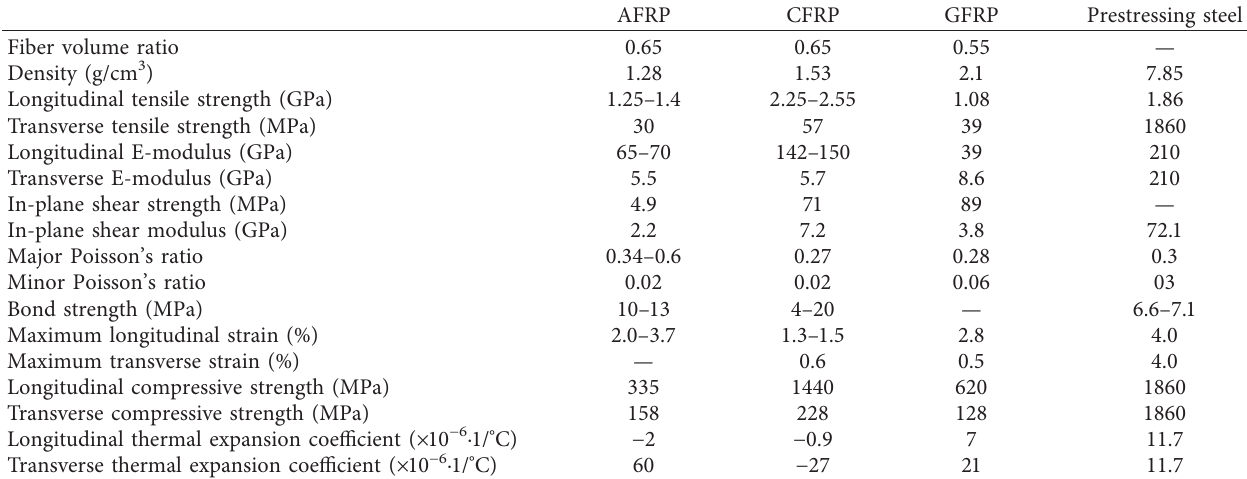
Table 4: The mechanical properties of FRP bars and prestressing steel [92].